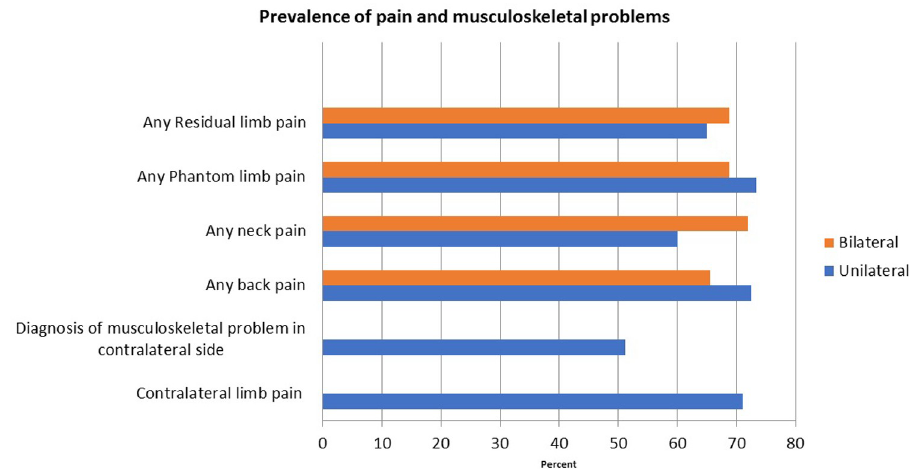
Fig 6. Prevalence of pain and musculoskeletal